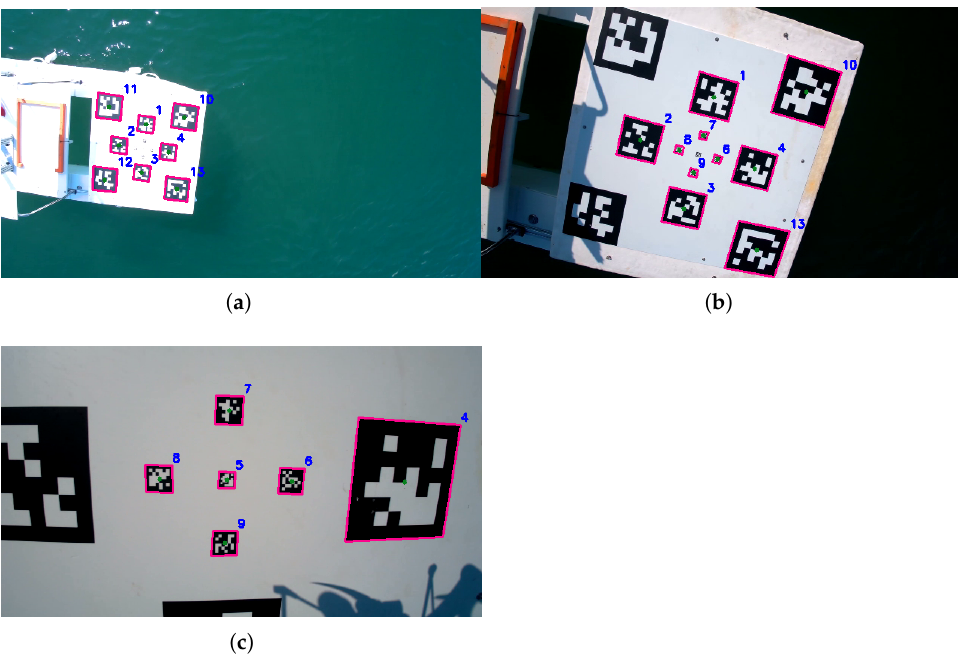
Figure 12. Detected tags at various altitudes: ( a ) initialization phase, high altitude; ( b ) tracking phase, medium altitude; ( c ) compensation phase, low altitude. Each detected tag is highlighted in magenta together with the tag identifier in